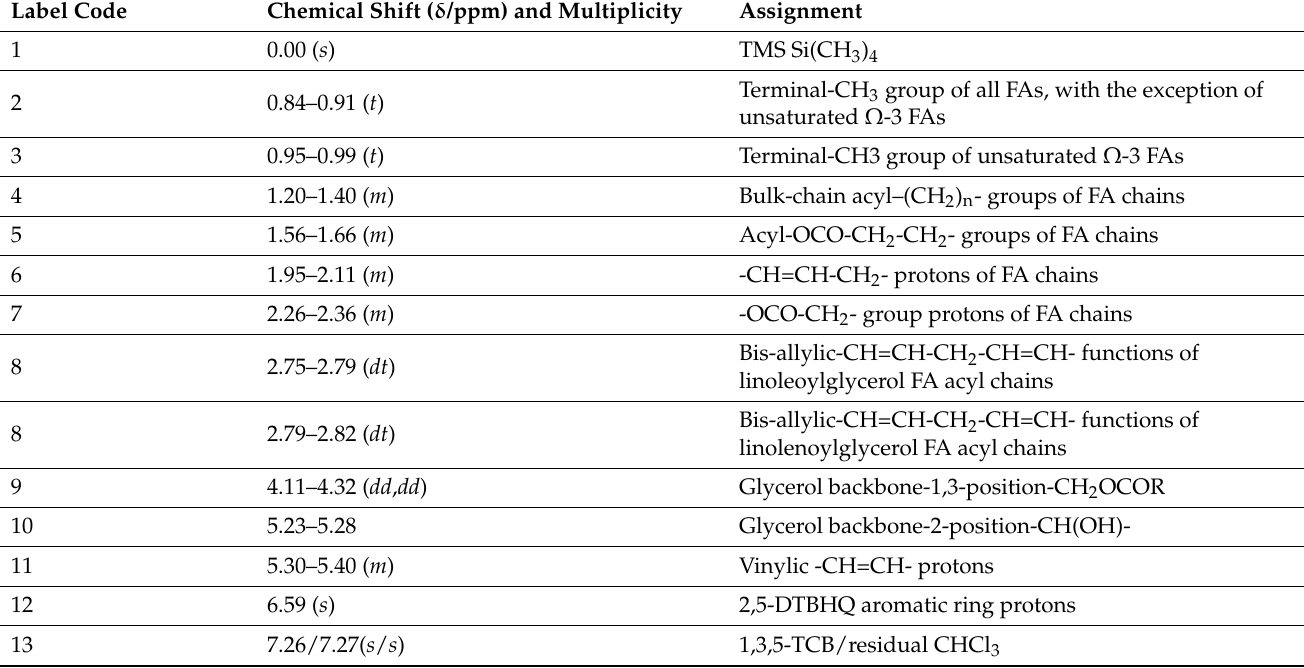
Table 1. Chemical shift values, multiplicities and assignments of the major TAG resonances in 1 H NMR spectra acquired on culinary oils at an operating frequency of 600 MHz. Coupling patterns are provided in brackets following the chemical shift values provided. The codes correspond to label assignments of the resonances shown in Figure 1. Abbreviations: TMS, tetramethylsilane; 2,5-DTBHQ, 2,5-dibydroxy- tertiary -butyl-hydroquinone (added chain-breaking antioxidant); TCB, 1,3,5-trichlorobenzene (quantitative internal standard); s , singlet; d , doublet; t , triplet; dd , doublet-of-doublets; dt , doublet-of- triplets; m ,